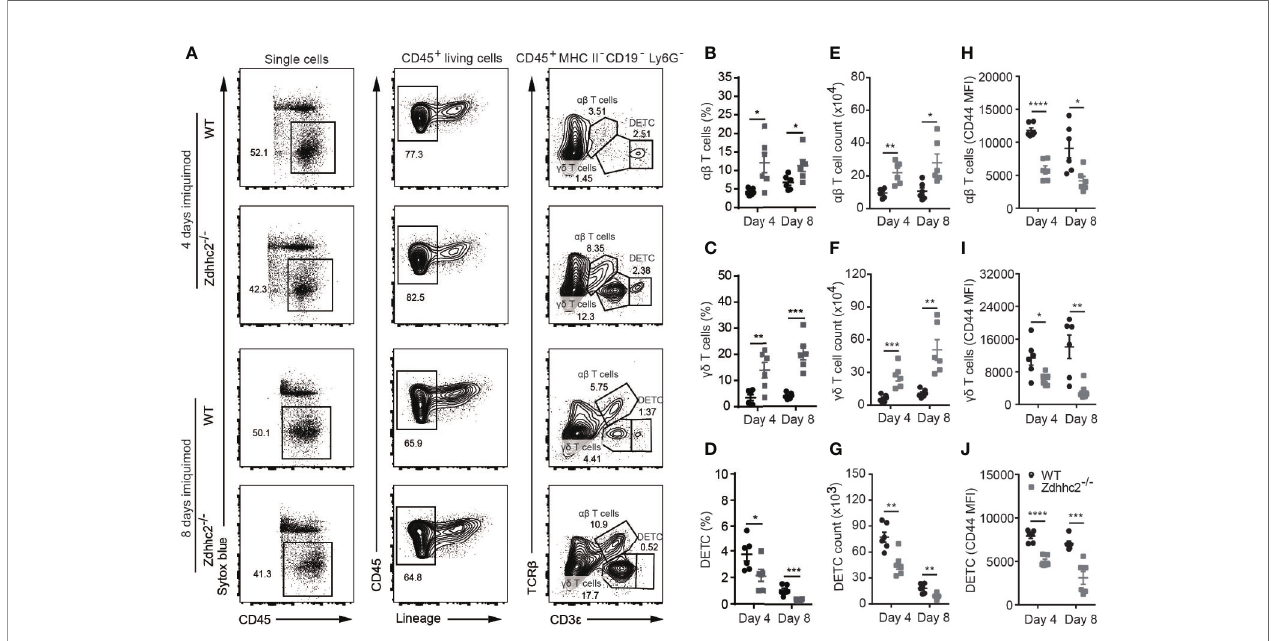
FIGURE 4 | T cell activation in the psoriatic skin of Zdhhc2 de fi cient mice. (A) Three groups of T cell gating strategy in psoriatic skin of WT and Zdhhc2 − / − mice after imiquimod treatment for 4 and 8 days, respectively. After excluding dead cells (Sytox blue positive), B cells (CD19 + ), neutrophils (Ly6G + ), and macrophages (MHC II + ), the remaining Lin − CD45 + cells were gated for CD3 ϵ low TCR b + , CD3 ϵ int TCR b − , CD3 ϵ high TCR b - which correspond to ab T cells, gd T cells, and DETC. (B – D) Comparison of the frequencies of three groups of T cells in WBC in the lesioned skin of WT and Zdhhc2 − / − mice after 4 and 8 days imiquimod stimulation. (E – G) Comparison the absolute cell number of ab T cells, gd T cells, and DETC in the psoriatic skin of WT and Zdhhc2 − / − mice after 4 and 8 days imiquimod stimulation. (H – J) MFI of CD44 for three groups of T cells in the lesioned skin of WT and Zdhhc2 − / − mice after 4 and 8 days imiquimod stimulation. Experiments were repeated twice, involving 3 mice for each time point per genotype (mean ± SEM). * p < 0.05, ** p < 0.01, *** p < 0.001, **** p < 0.0001, unpaired Student ’ s t-